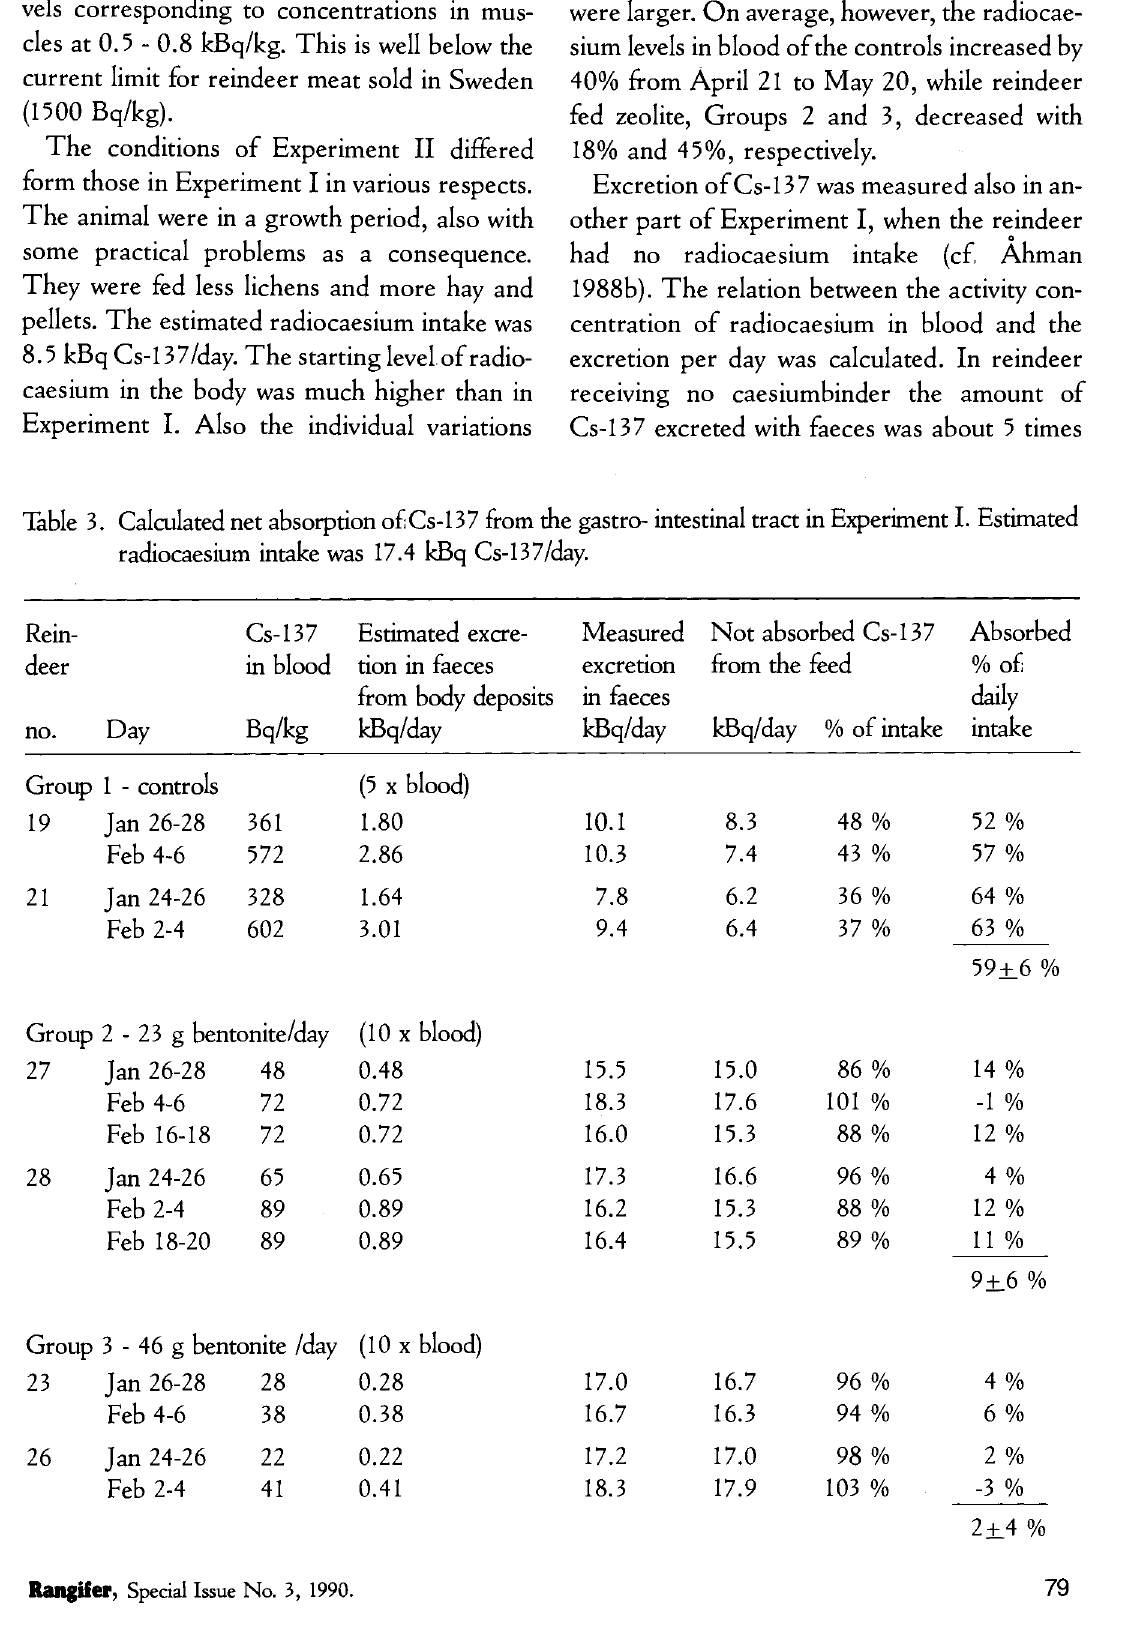
Table 3. Calculated net absorption of Cs-137 from the gastro- intestinal tract in Experiment I. Estimated radiocaesium intake was 17.4 kBq